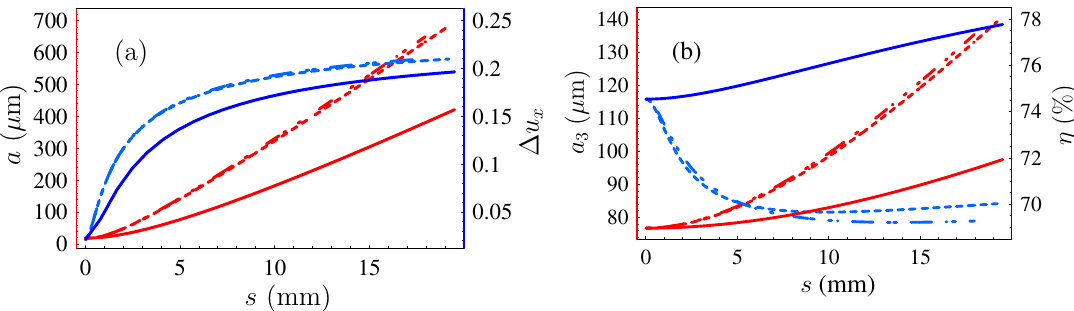
FIG. 8. (Color) Simulation of the space-charge blowup of a large energy spread long electron bunch with input parameters: Charge (cid:1) 8 : 5 MeV , radius a (cid:1) 19 (cid:4) m , half-length a (cid:1) 76 : 8 (cid:4) m , energy spread (cid:5) (cid:1) 74 : 5% , divergence Q (cid:1) 1 : 6 nC , beam energy E 0 3 (cid:1) 3 mrad , typical distance between macroparticles n (cid:6) 1 = 3 ’ 1 : 8 (cid:4) m , and cutoff radius r (cid:1) 1 (cid:4) m . Evolution of (a) transverse x 0 0 max 0 radius a and transverse RMS momentum spread (cid:1) u , (b) longitudinal half-length a and energy spread (cid:5) as a function of propagation x 3 distance s is shown using the envelope model (solid), 3D-PPI (dashed), and shell method (dot-dashed).